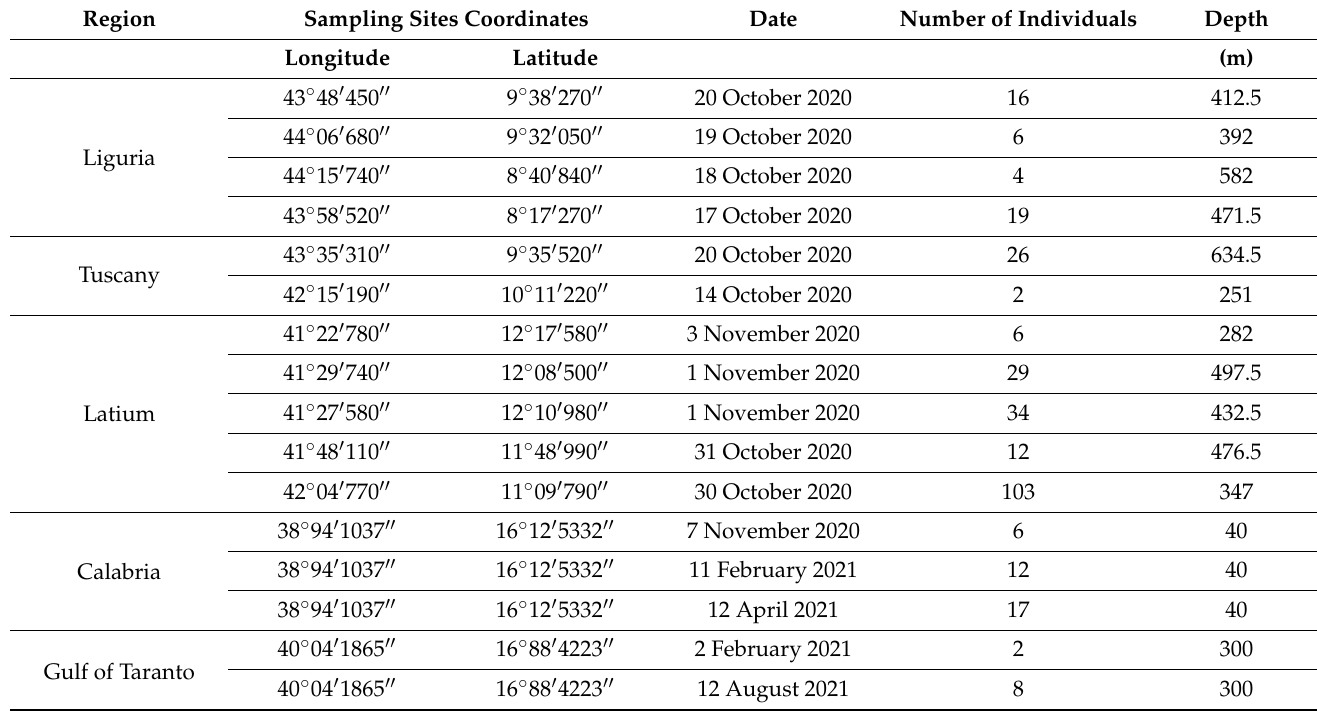
Table 1. Summary of the regional location, longitude, latitude, date, number of individuals and depth for sampling